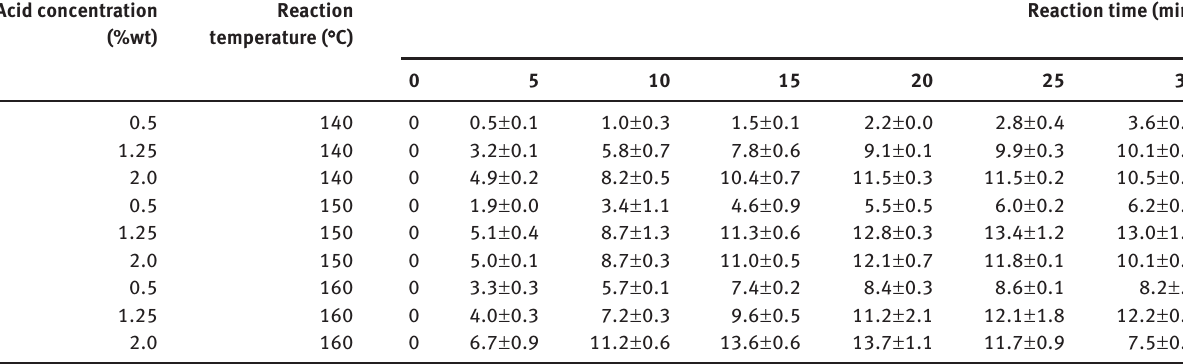
Table 3 Concentration of xylose in the liquid hydrolyzate samples, g/l. Acid concentration